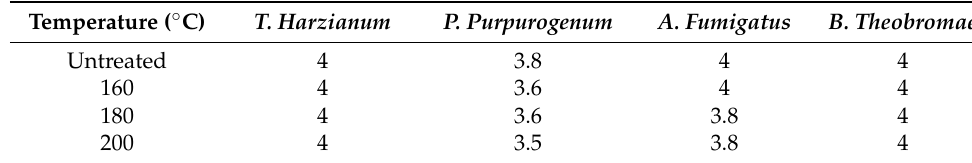
Figure 11. Surfaces of bamboo scrimbers stained by (T) T. harzianum , (P) P. purpurogenum , (A) A. fumigatus and (B) B. theobromae . Table 4. Infection value of bamboo scrimbers by four species of mildews.